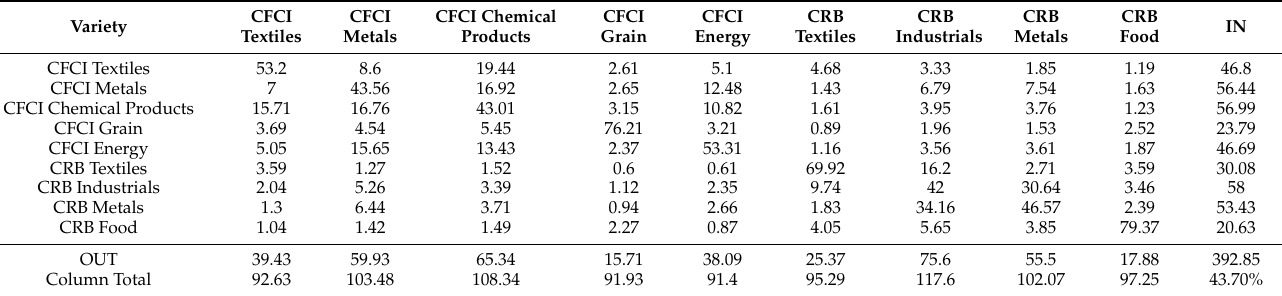
Table 2. Volatility spillover matrix between